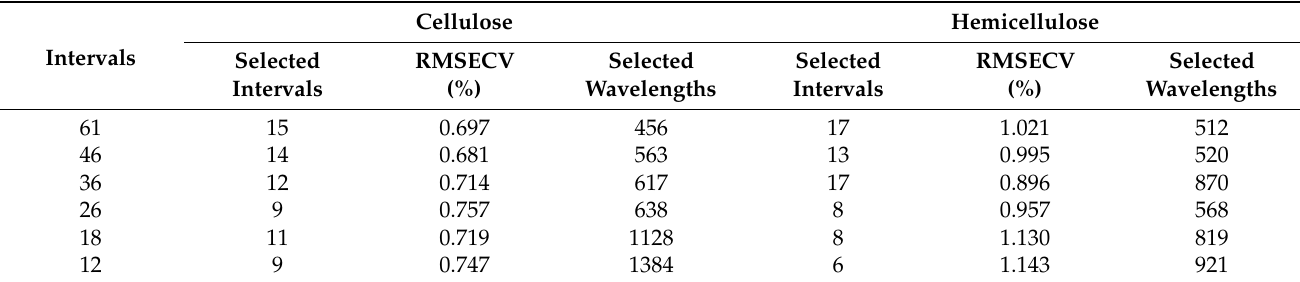
Table 2. Preliminary selection results of spectral characteristic intervals for cellulose and hemicellu- lose, optimized using